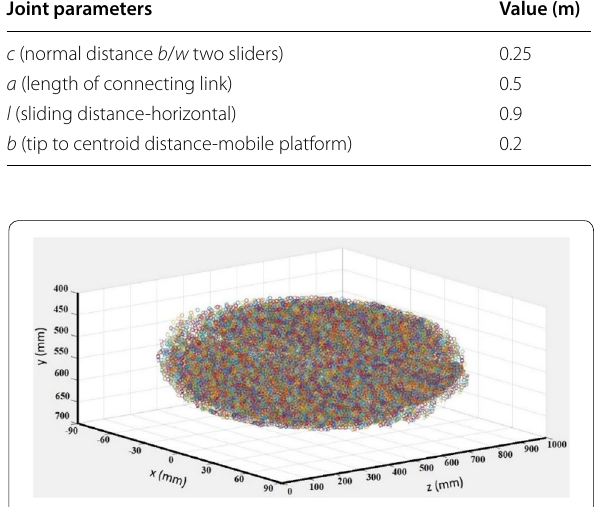
Figure 9 Reachable points for the 3-PRUS Parallel manipulator